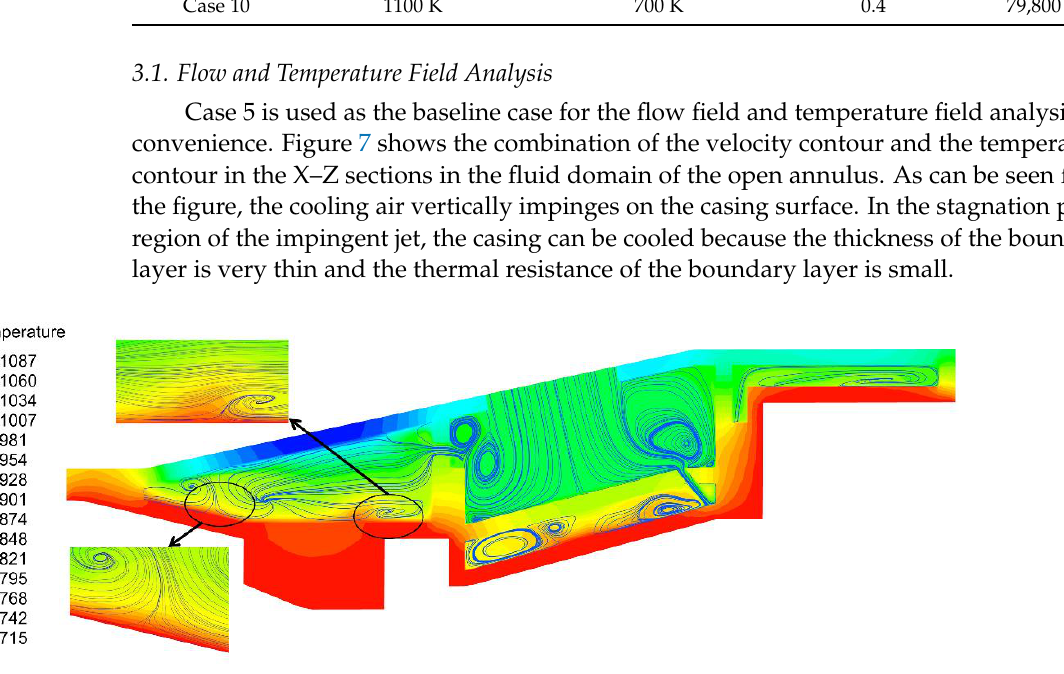
Table 4. Simulation examples.